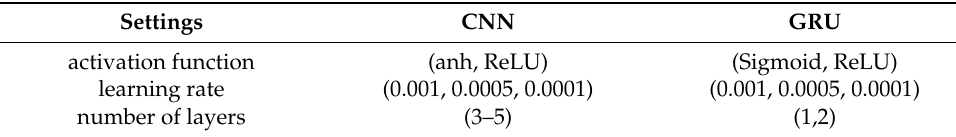
Table 1. Overview of the optimization